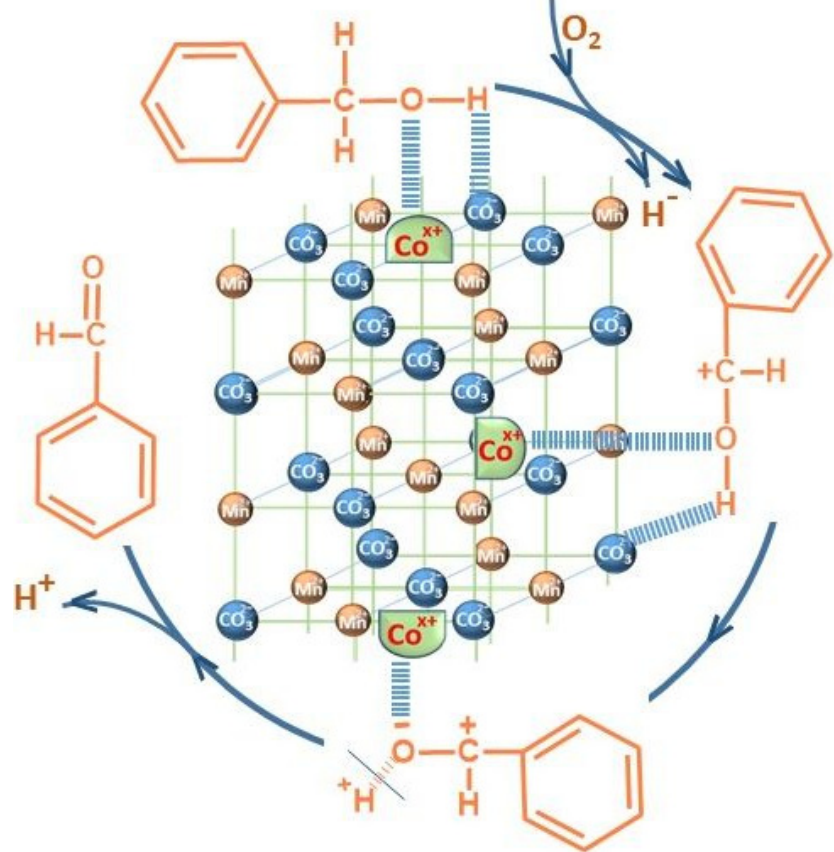
Figure 10. A plausible mechanism detailing the reaction pathway for oxidation of benzyl alcohol to benzaldehyde on the (1%)Co x O y –MnCO 3 surface.